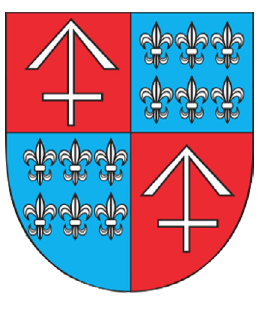
Figure 10. The former arms of Rydzyna.